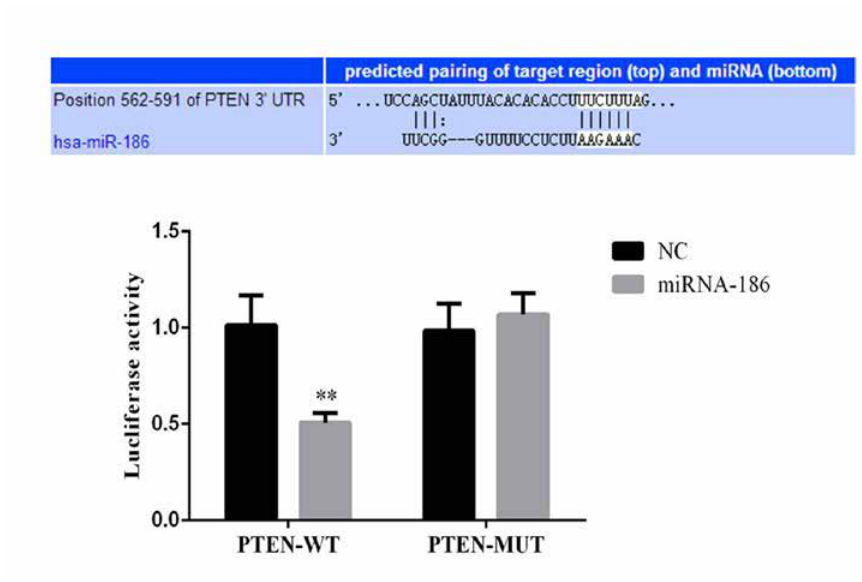
Figure 4: Dual luciferase target assay, **:P < 0.05, compared with NC